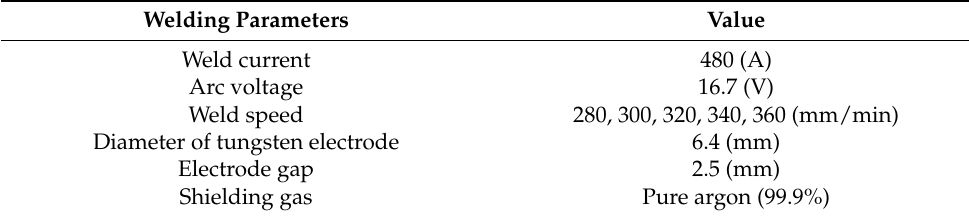
Table 1. Test parameters.